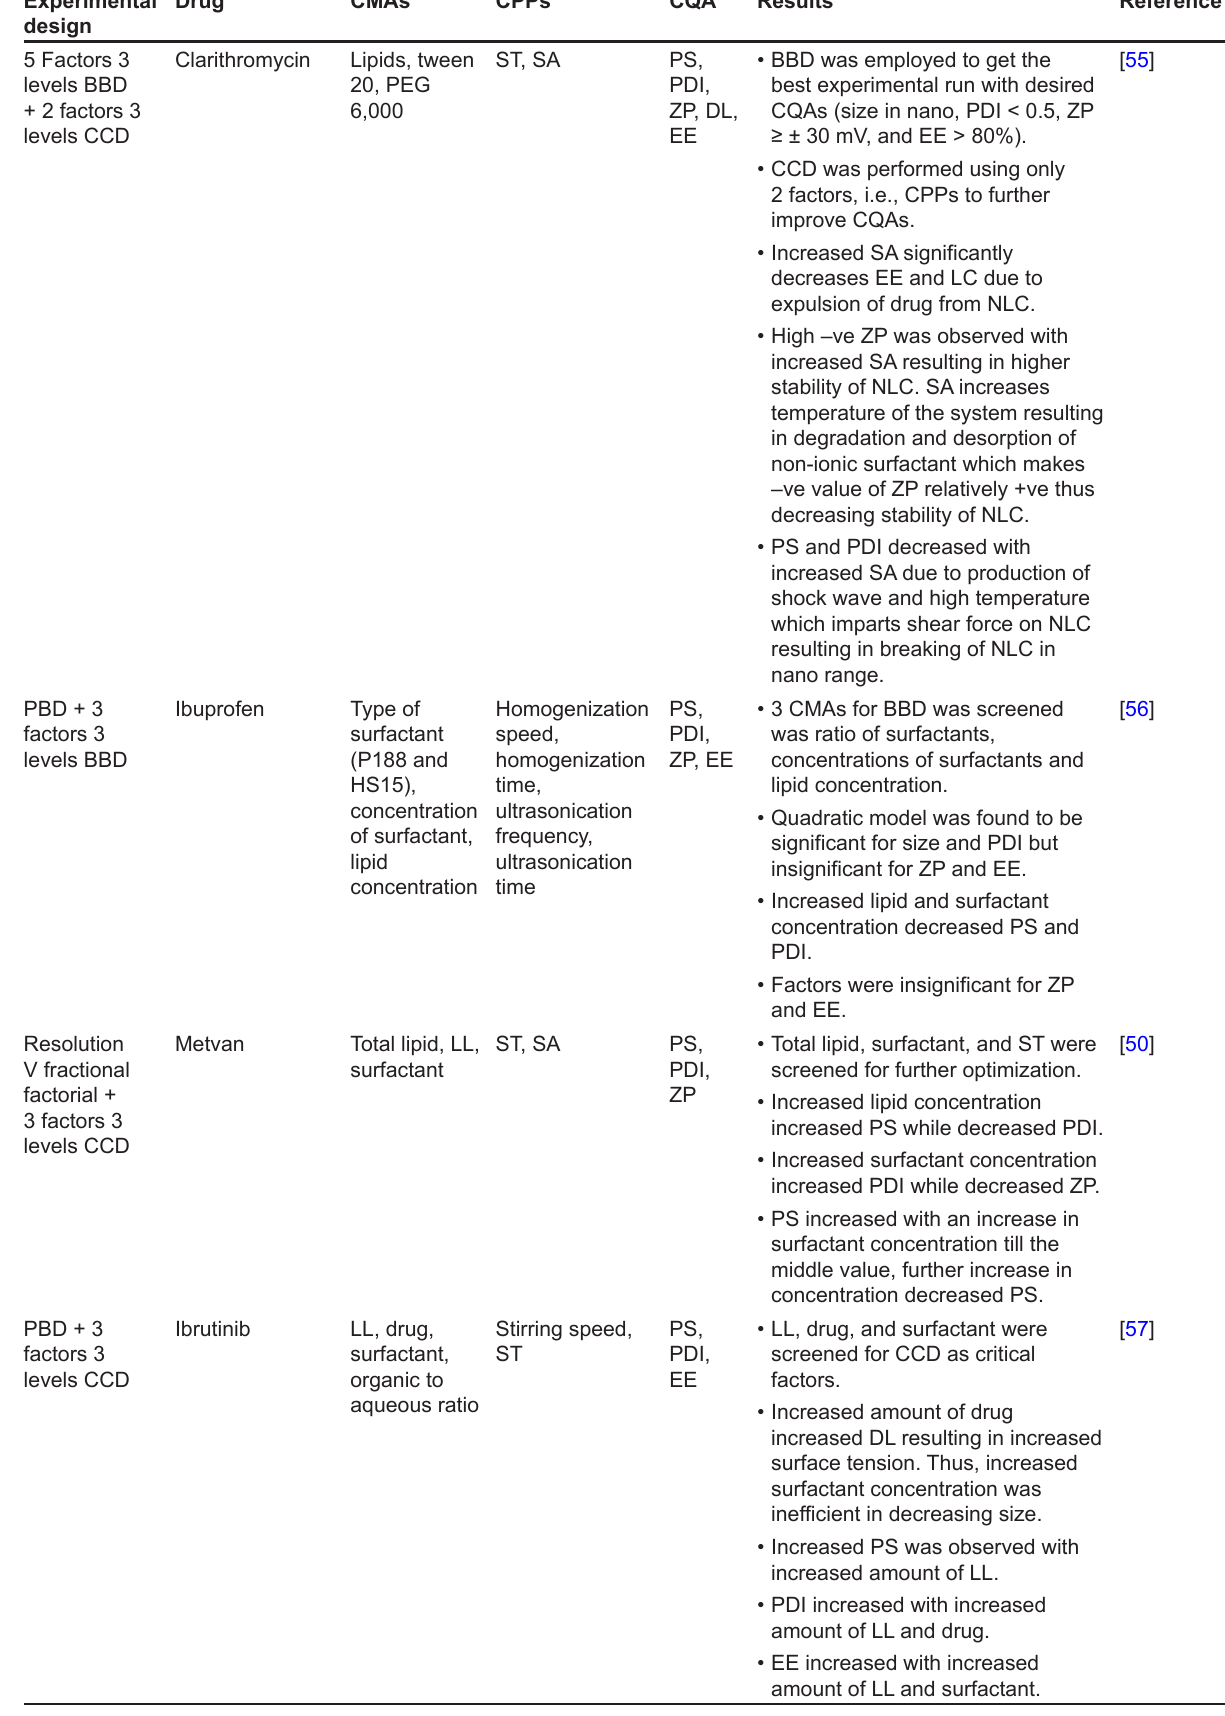
Table 4. Summary of optimization results by the application of QbD on NLC ( Continued )